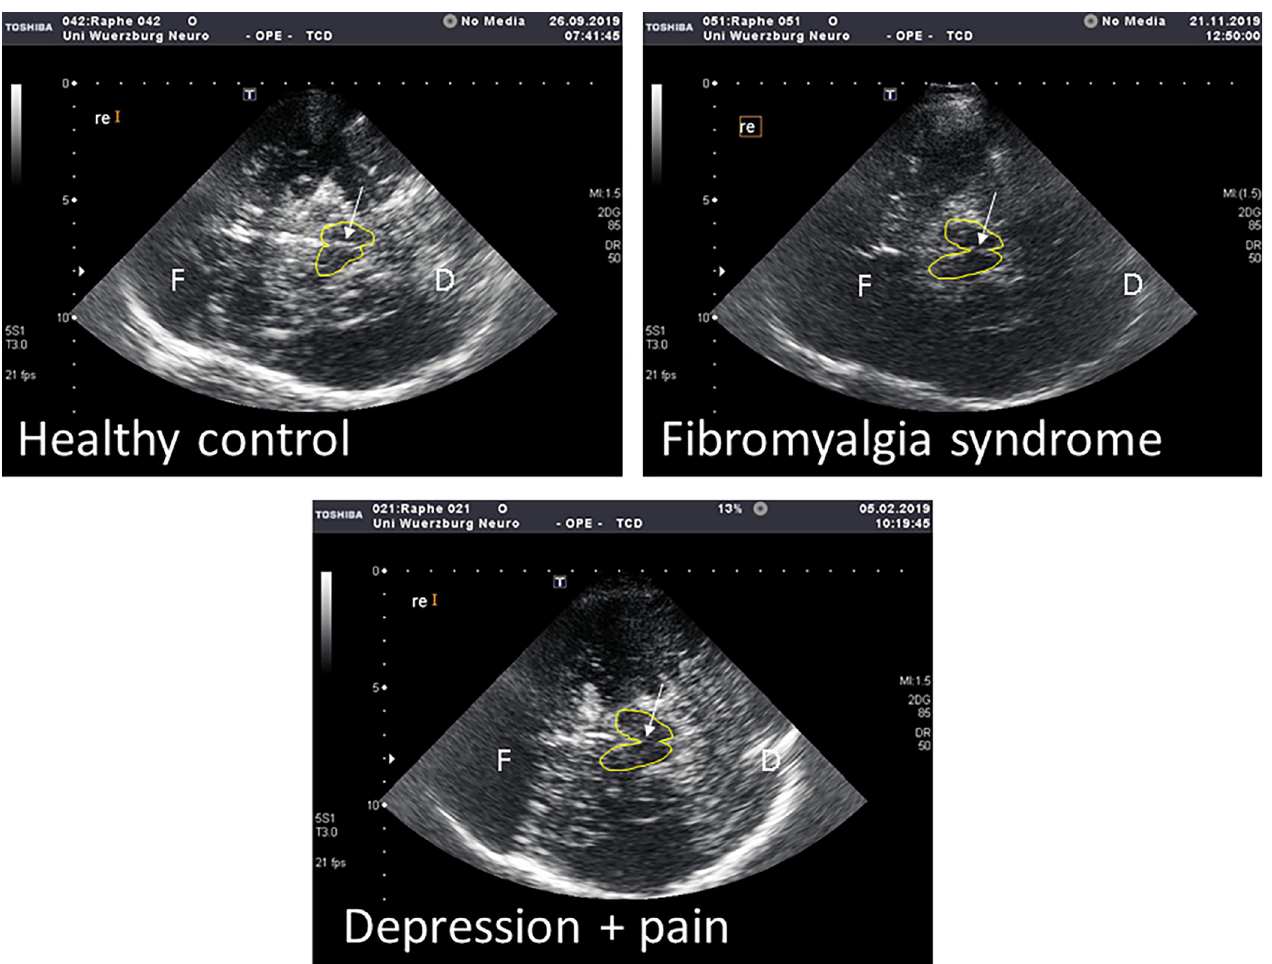
Fig 1. Exemplary midbrain raphe sonograms. Transcranial axial sonogram of the midbrain in (A) a healthy woman, (B) a woman with fibromyalgia syndrome, and (C) a woman with depression and physical pain. Midbrain raphe echogenicity (arrow) is markedly lower in B and C compared to A. The midbrain is outlined in yellow. For orientation: F = frontal, D =